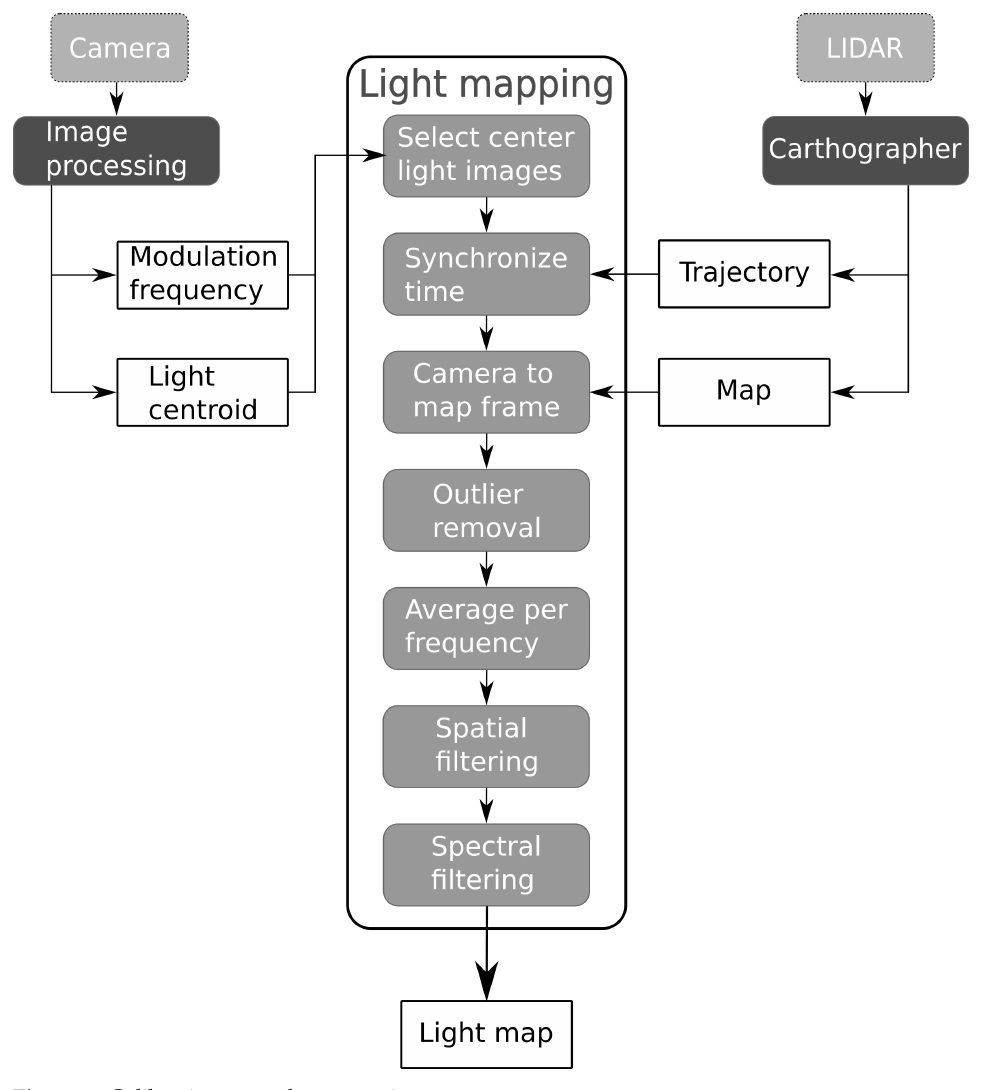
Figure 4. Calibration procedure overview. Table 3. Calibration